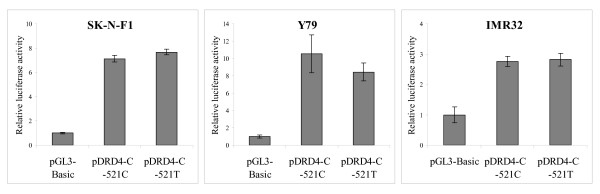
The effect of the -521 C/T SNP on the transcriptional activity of the DRD4 minimal promoter in neural cell lines. No significant difference could be detected between the transcriptional activities of the pDRD4-C constructs possessing the -521 C or T alleles in any of these cell lines. Luciferase activity was normalized to the β-galactosidase activity. Data are presented as fold increments over the pGL3-Basic activity and shown as mean ± SD. Results of a representative experiment are shown as measured in triplicates. Similar data were obtained from three independent transfection experiments.